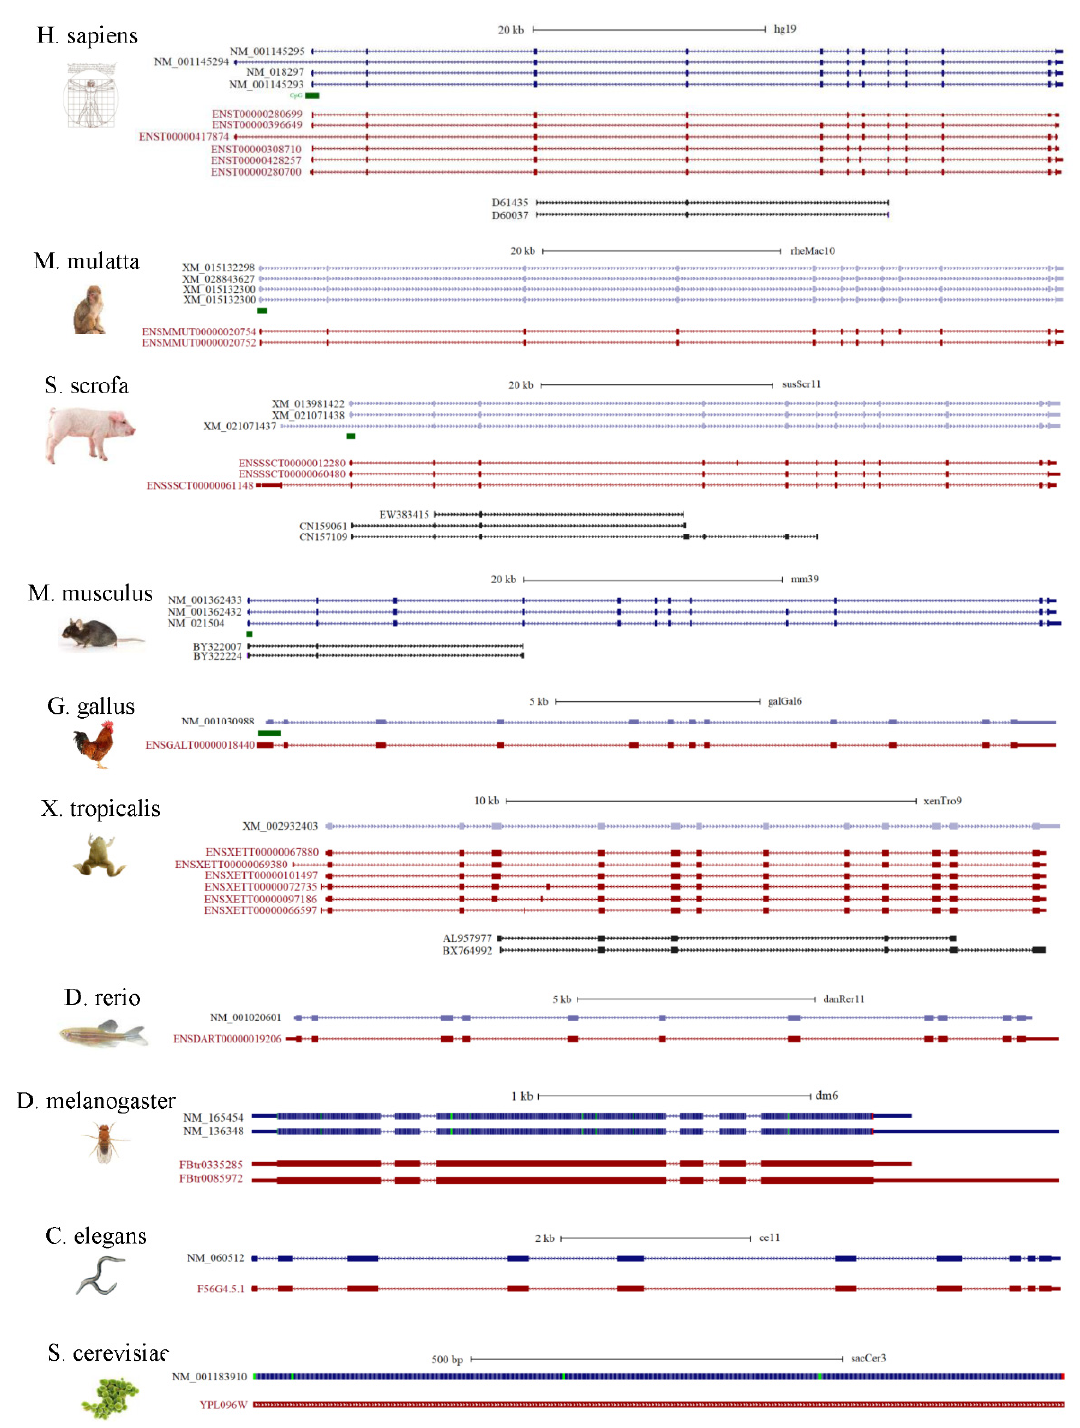
Figure 7. Alternative splicing patterns of NGLY1 in different species.